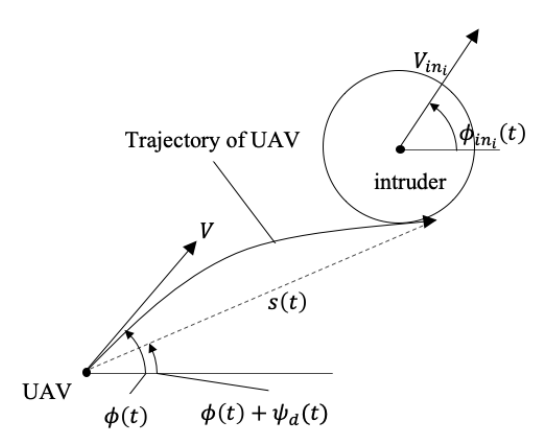
Figure 3. Collision avoidance geometry of a UAV to an